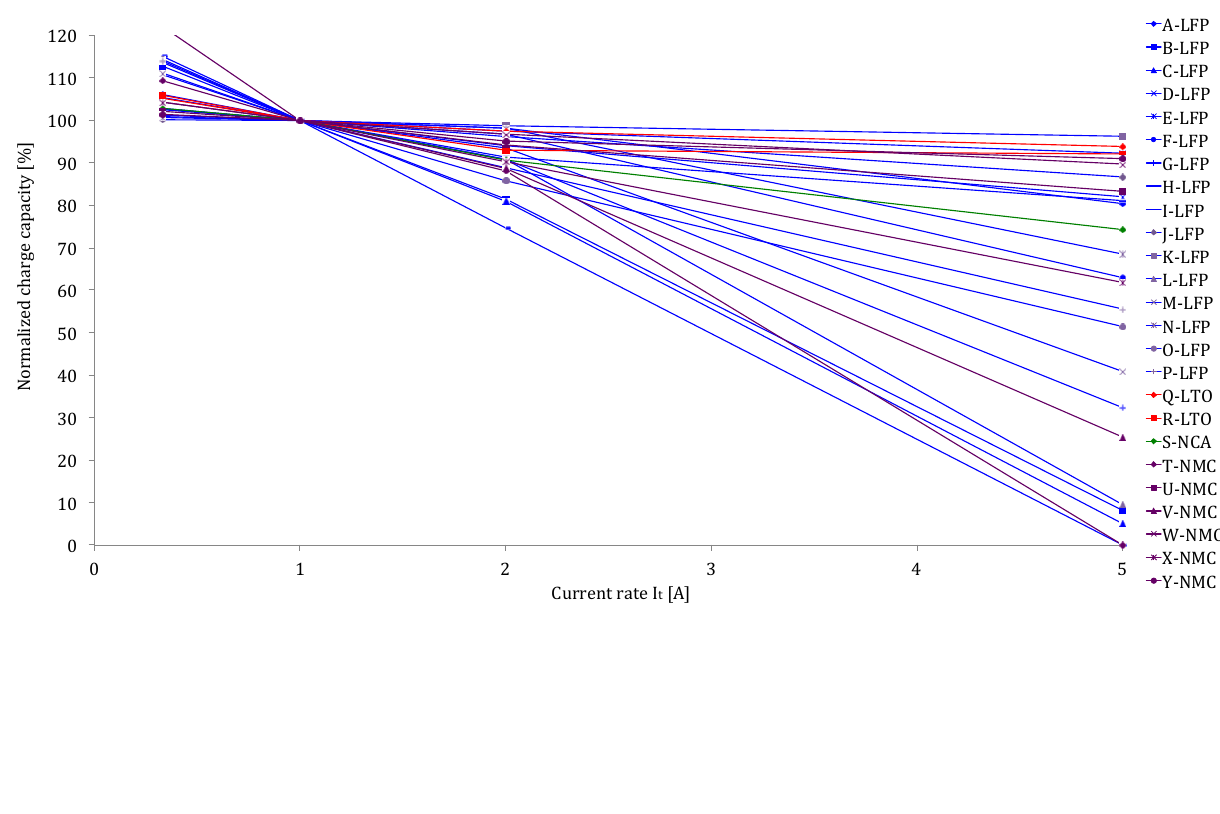
Figure 21. Charge performances of lithium-ion brands and